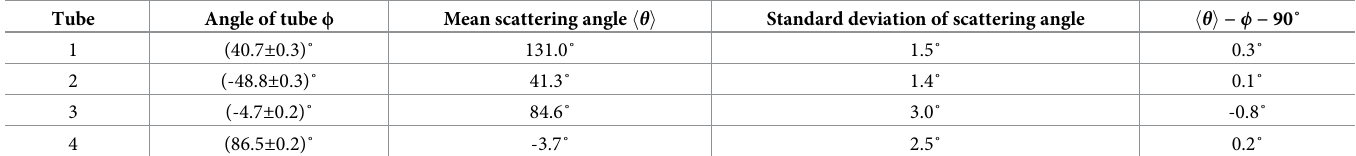
Table 1. Measured tube angles ϕ and associated main scattering directions θ (both relative to the horizontal axis of the detector). Results were obtained with 25 dif- fuser positions and analysis window size of 31 × 31 pixels. Tube Angle of tube